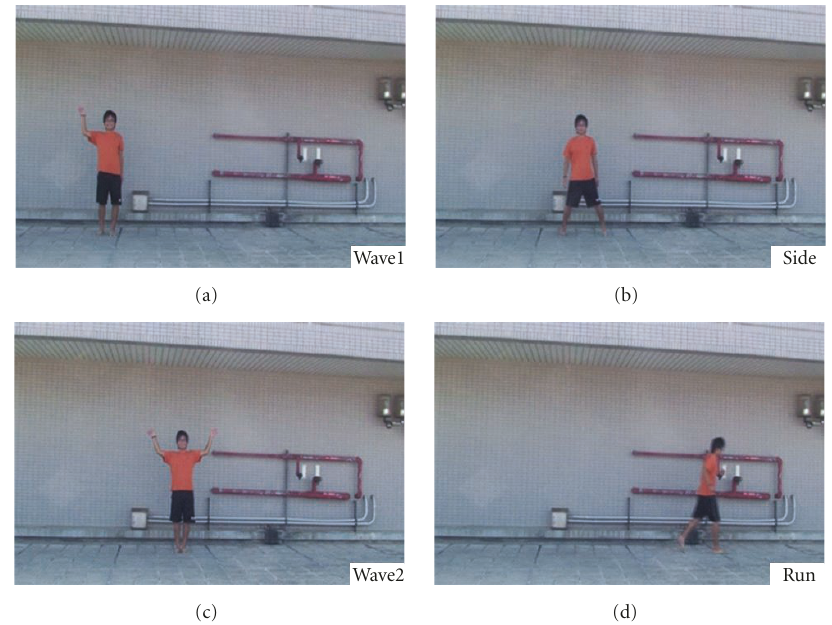
Figure 11: Action recognition in a single video sequence.